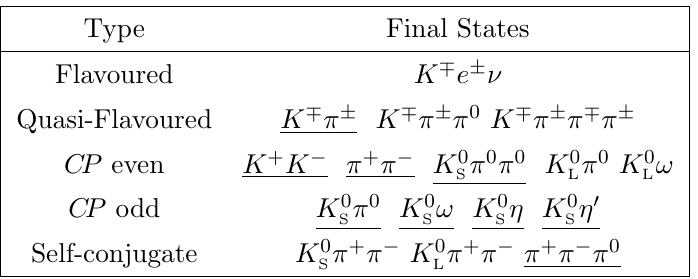
Table 1 . List of all D decay (cid:12)nal states that are reconstructed in conjunction with a D ! 4 (cid:25) (cid:6) decay (double-tag modes). The underlined (cid:12)nal states are also reconstructed alone (single-tag